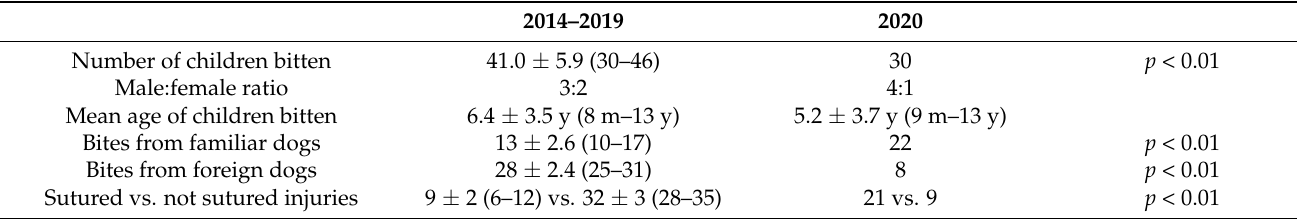
Table 1. Summary of the demographic data of the population along with p -values of the variables studied. The 2014–2019 are reported as mean yearly values ± standard deviation and ranges are reported between round brackets. m: months; y: